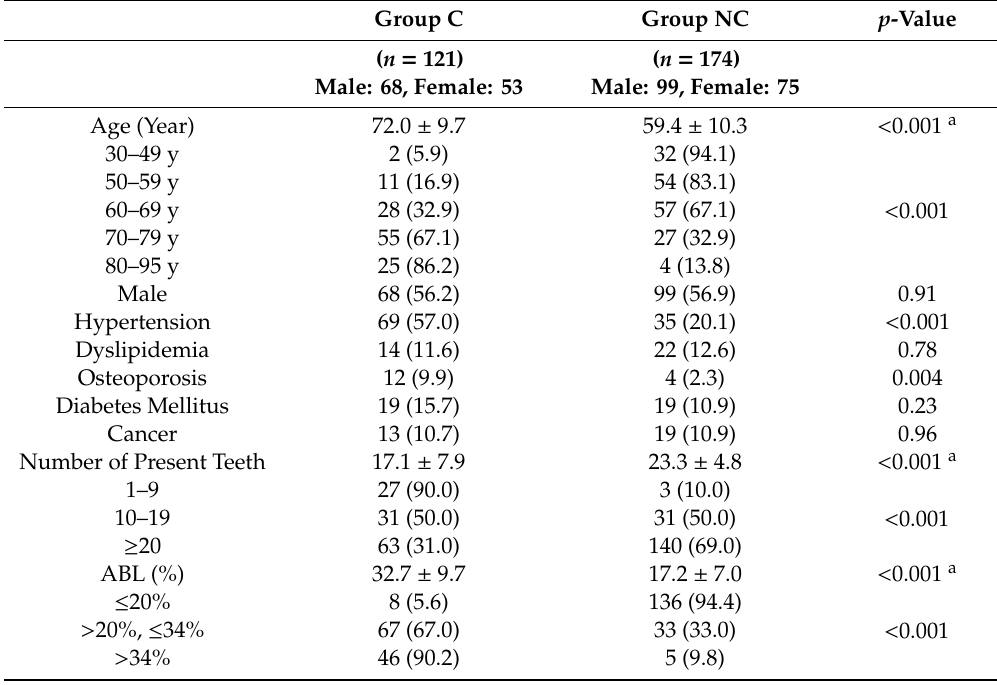
Table 2. The relationship between carotid artery calcification and other variables.